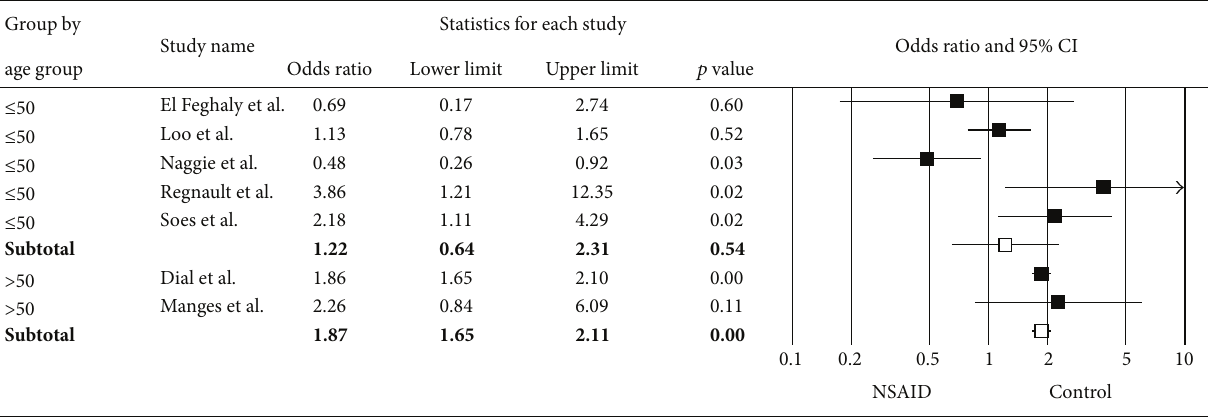
Figure 5: Forest plot of subgroup analysis by age